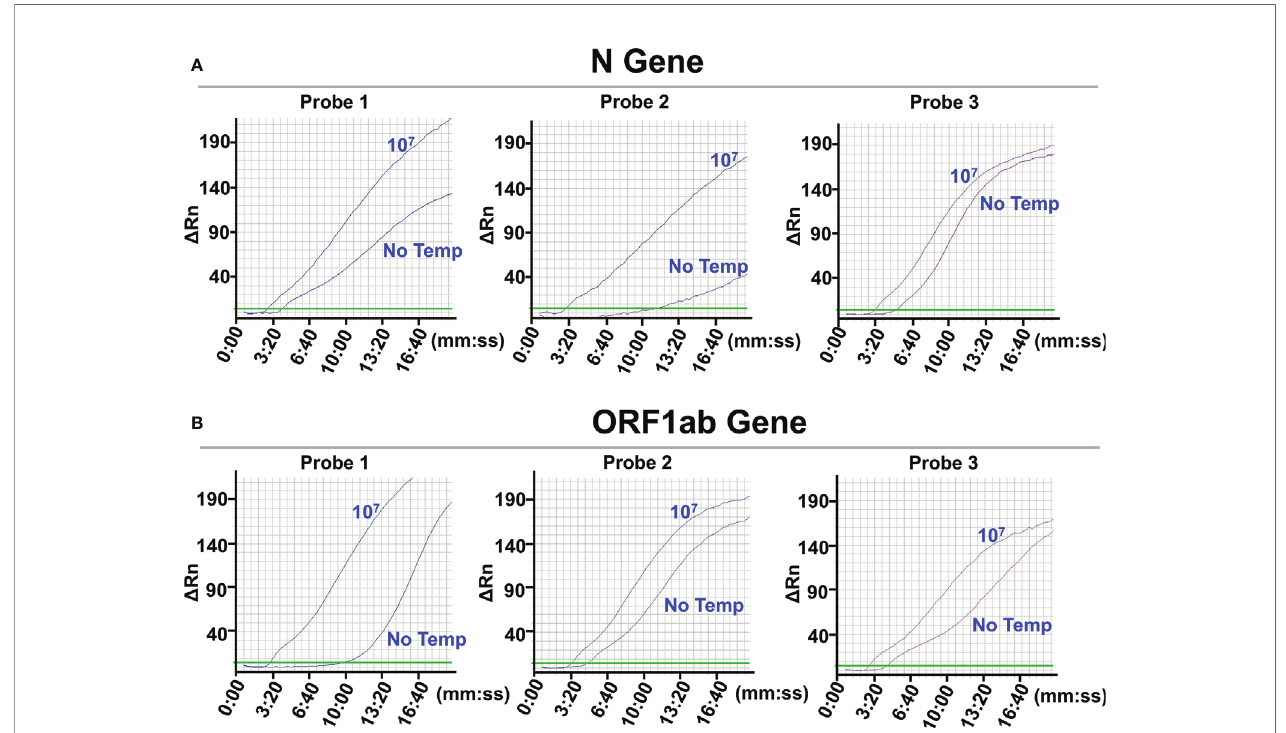
FIGURE 2 | Selection of the detection biomarkers. The images were the fl uorescence history diagrams of RPA ampli fi cations of the ligation products from the N gene RNA standard template (A) and the ORF1ab gene RNA standard template (B) . The diagrams showed the fl uorescence signal ( D Rn) vs . time (mm:ss). For each target gene, 3 potential detection biomarkers were targeted by ligation probe pairs 1, 2, and 3 that were indicated at the top of the respective diagrams. The curves indicated with “ 10 7 ” represented ampli fi cation signals from ligations with 10 7 the RNA templates. The curves indicated with “ No Temp ” represented ampli fi cation signals from the ligation controls with no RNA template. Every diagram was one typical outcome of three independent